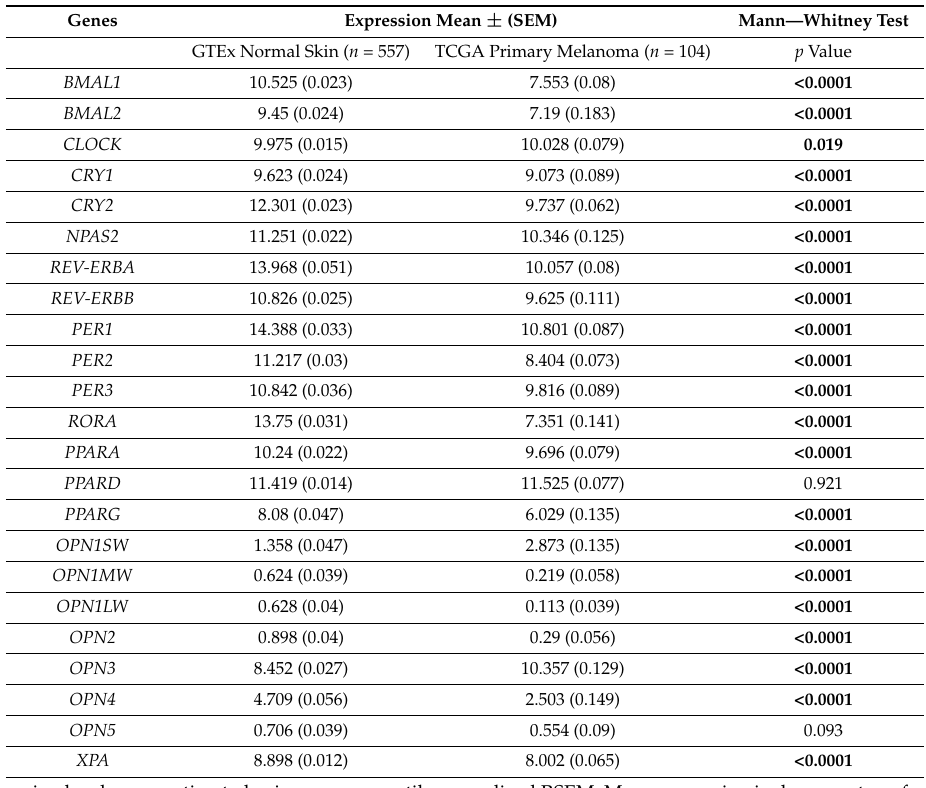
Figure 3. The molecular clock machinery is repressed in human primary melanomas compared to normal skin. Unsupervised hierarchical clustering of 557 GTEx normal (sun and non-sun exposed) skin samples and 104 TCGA primary melanomas according to the expression of clock and clock-controlled genes. Clusters were defined based on the Euclidean distance using complete linkage. Table 2. Comparison of gene expression between human healthy skins and primary